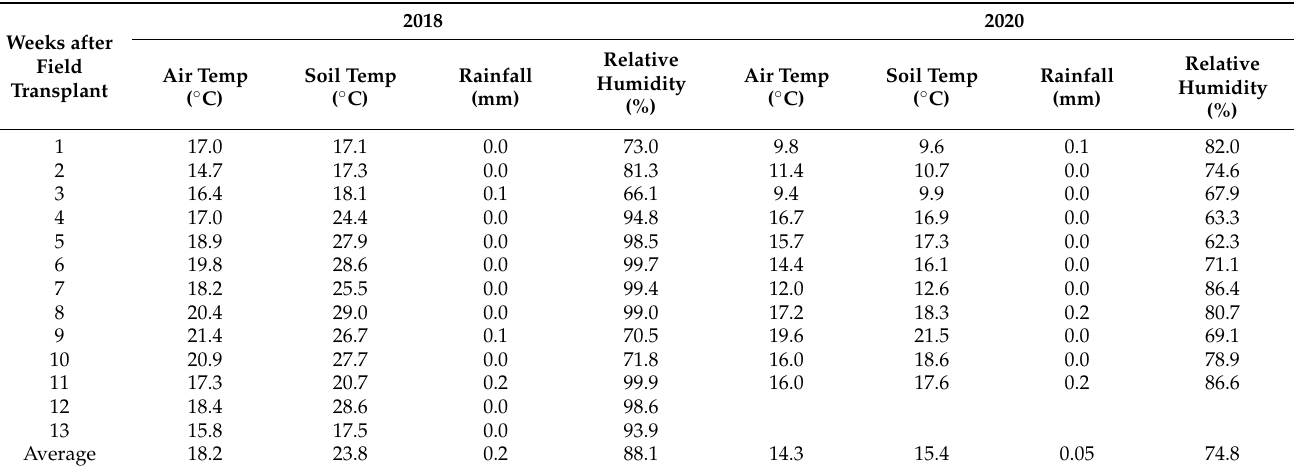
Table 3. Environmental data recorded at the nearest weather station to the farm of celery growth and provided by G’s Fresh. Weeks after Field